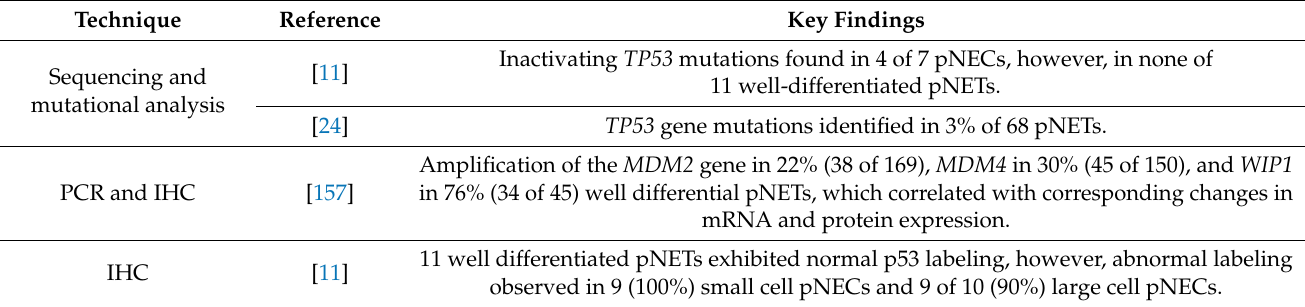
Table 6. Molecular profiling studies revealing p53 pathway alterations in